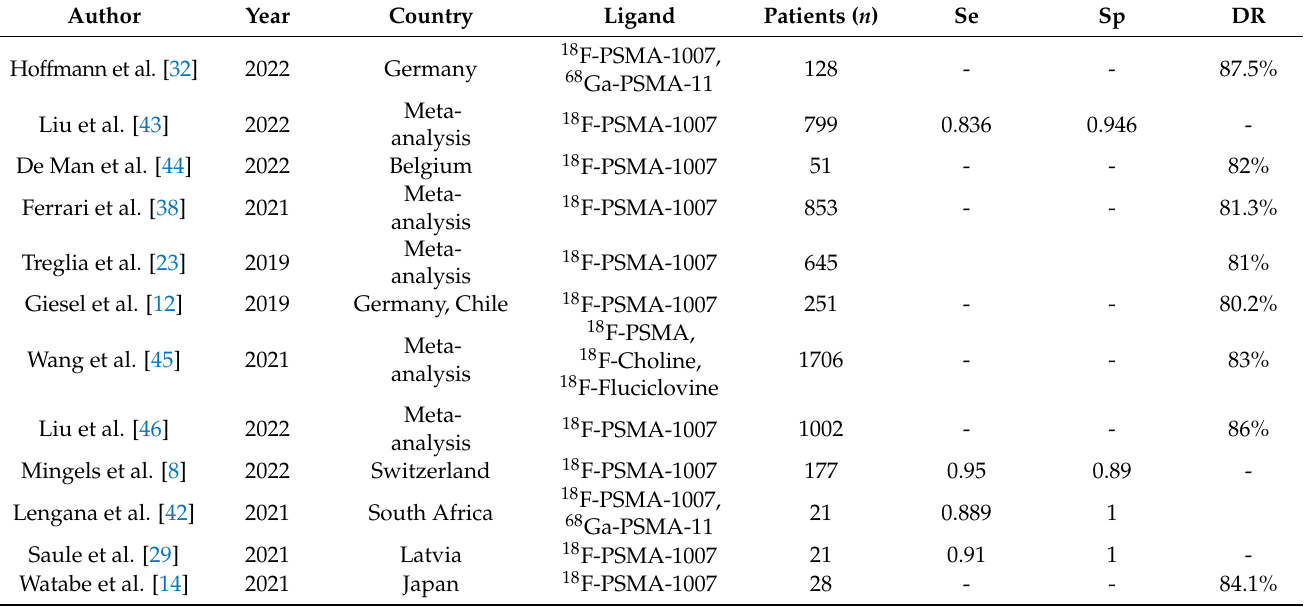
Table 3. PET/CT performance in detection of local recurrence.